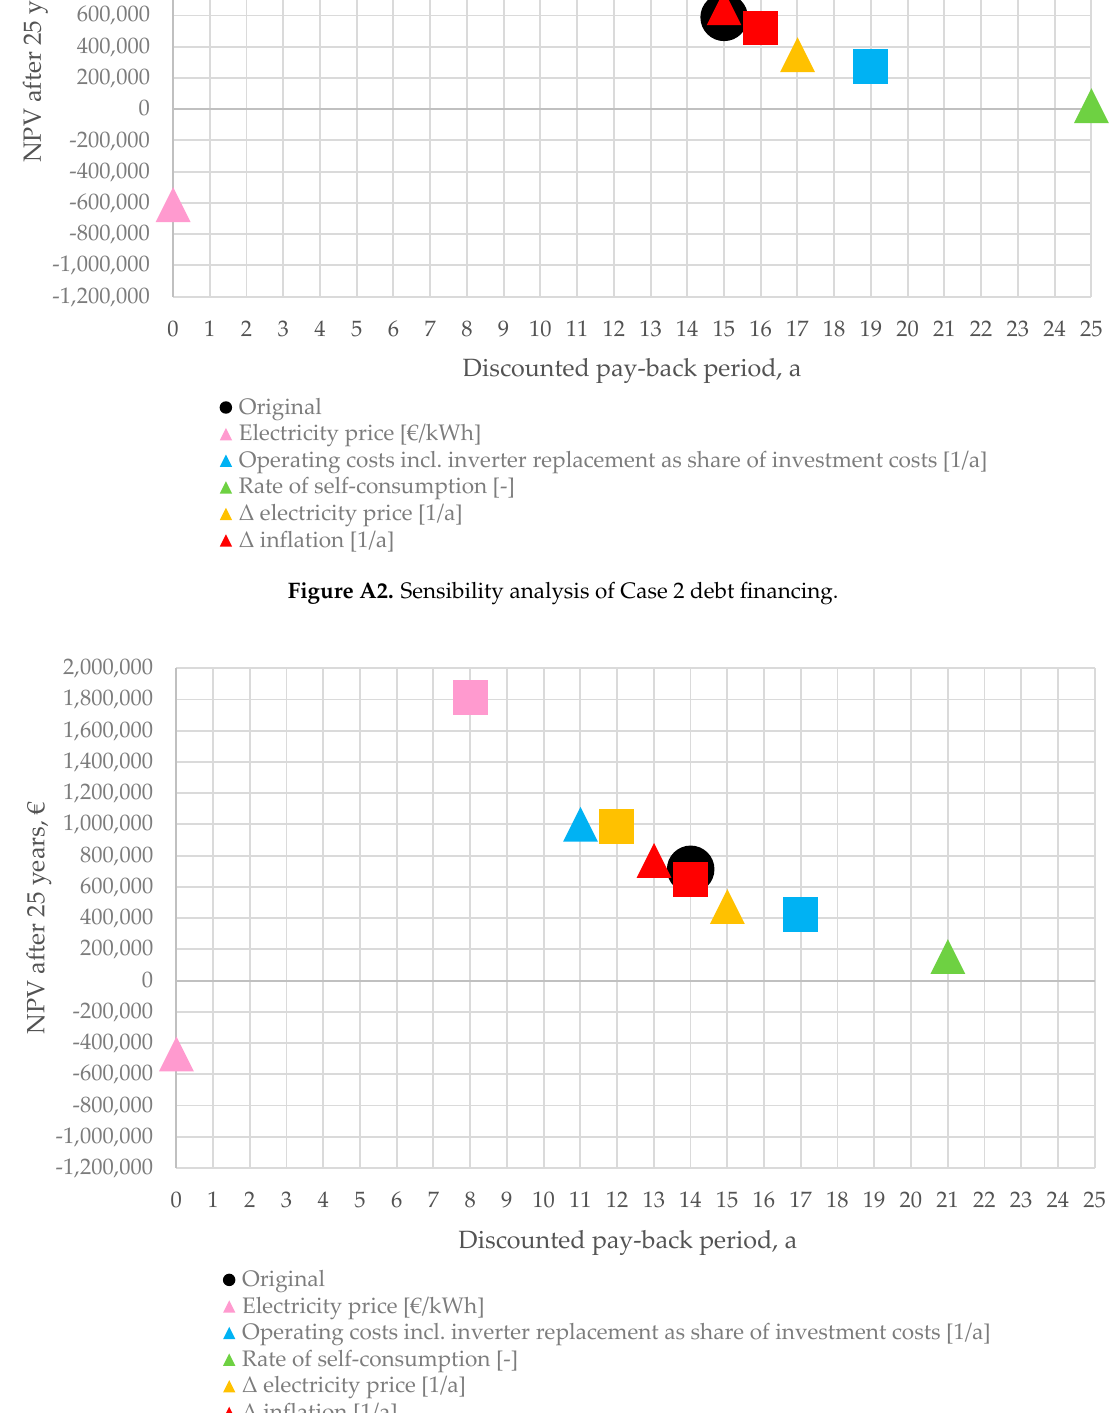
Figure A4. Sensibility analysis of Case 1 CPI-financing.